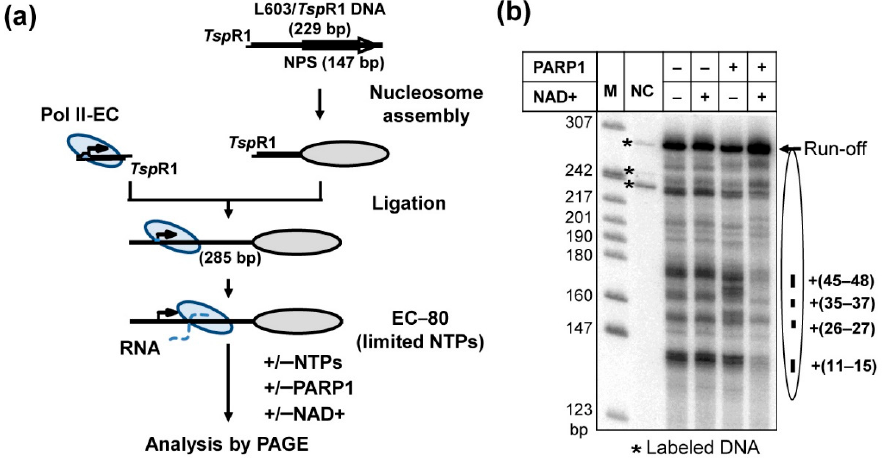
Figure 1. Experimental approach for analysis of the effect of PARP1 on transcription through a nucleosome. ( a ) In vitro transcription assay for analysis of the effect of PARP1 on transcription through a nucleosome by yeast Pol II. yPol II elongation complex (yPol II-EC, the arrow indicates direction of transcription) was assembled and ligated to the nucleosome assembled on the 603 nucleosome positioning sequence (NPS) via TspRI ends. EC-80 was formed in the presence of ATP, CTP, and [ α - 32 P] GTP (-UTP reaction [36] ). The numerical index of EC indicates the position of the yPol II active center relative to the promoter–proximal nucleosomal boundary. Then, transcription through the nucleosome was continued in the presence of an excess of all unlabeled NTPs and/or PARP1 and NAD+. ( b ) PARP1 facilitates transcription through 603 nucleosome in the presence of NAD+. Transcription through the nucleosome was conducted in the absence or presence of PARP1 and NAD+. Analysis of pulse-labeled RNA by denaturing PAGE. Positions of the nucleosome and the major pausing sites are indicated on the right. Labeled DNA fragments are indicated by asterisks. NC— no chase. M: end-labeled pBR322-MspI digest.